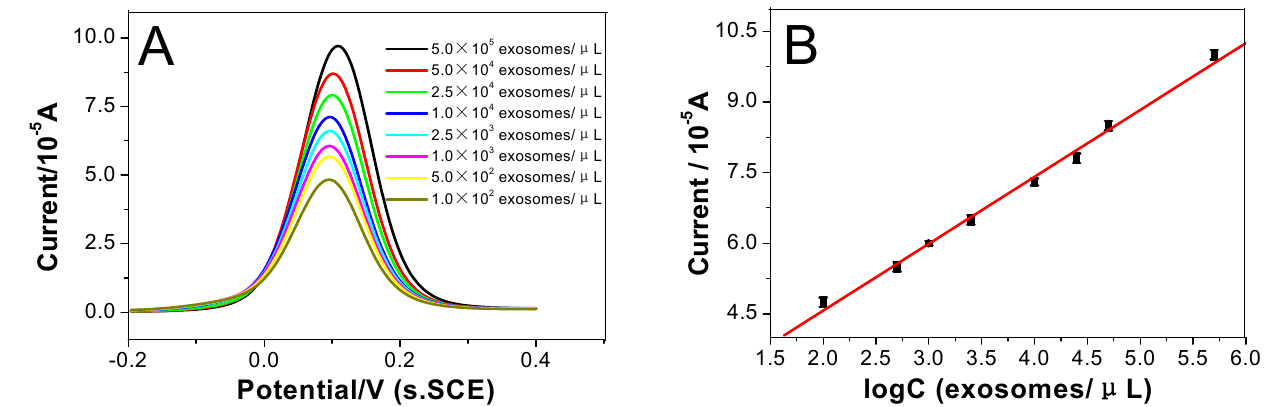
Figure 6. ( A ) DPV responses of the proposed immunosensor after incubation with various concentrations of exosomes in [Fe(CN) 6 ] 4 − /3 − . (From down to top, concentrations of exosomes are: 1.0 × 10 2 , 5.0 × 10 2 , 1.0 × 10 3 , 2.5 × 10 3 , 1.0 × 10 4 , 2.5 × 10 4 , 5.0 × 10 4 , 5.0 × 10 5 exosomes µL − 1 ); ( B ) Linear relationship between the current I of the immunosensor and logarithm of exosome concentration. Error bars represent the standard deviation, n = 5. Table 1. Comparison of the response characteristics of various modified